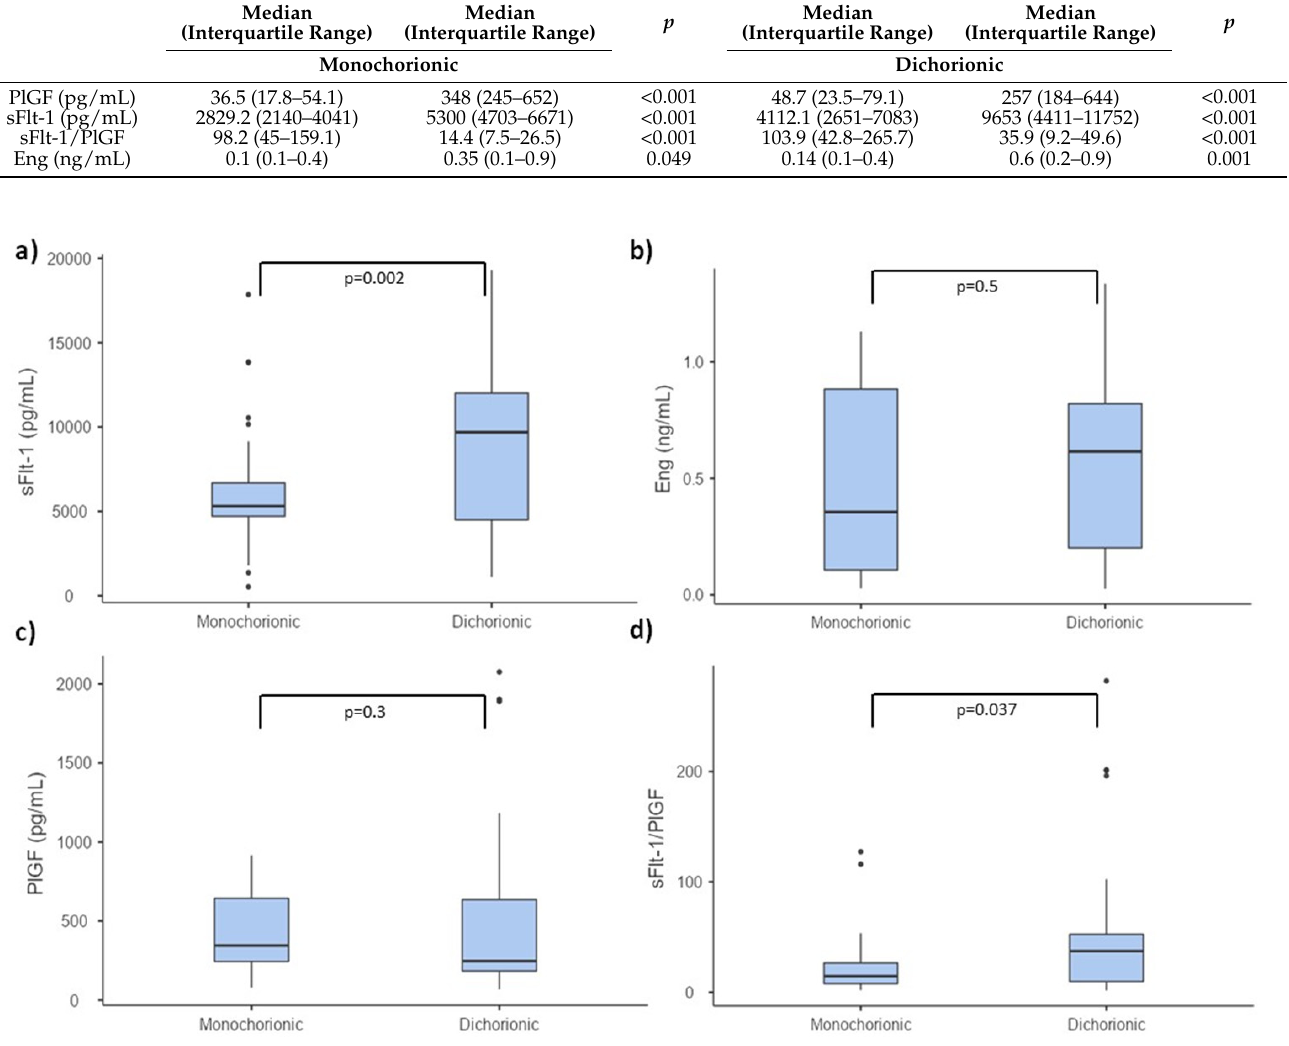
Table 3. Serum concentrations of PlGF, sFlt-1, sFlt-1/PlGF and Eng measured in the first trimester and the third of pregnancy in monochorionic and dichorionic groups without hypertension-related disorders.